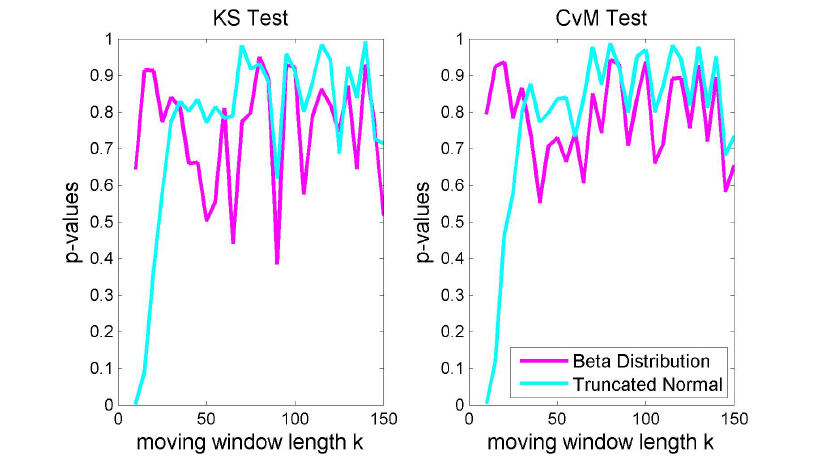
Figure 5. Different measures of fit for correlation.